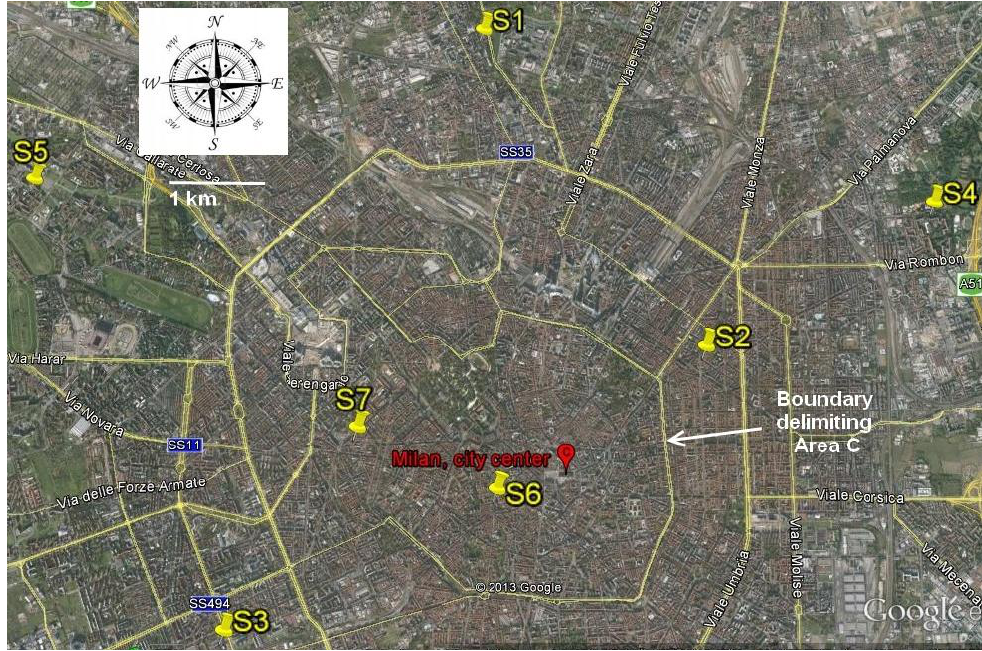
Figure 1. Location of study schools (S1 to